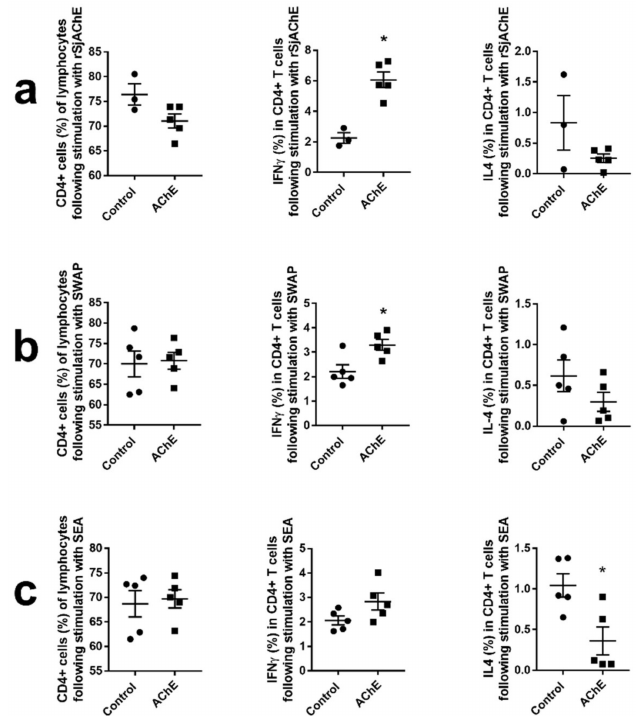
Figure 6. Cytokine profiles of splenocytes recovered from SjAChE-vaccinated and control mice at 6 weeks post- challenge. CD4 + T cells as a percentage of total lymphocytes and production of IFN γ and IL-4 in splenic CD4 + T cells isolated from vaccinated mice compared with controls following stimulation with ( a ) rSjAChE protein; ( b ) SWAP and ( c ) SEA for 3 days. * = p value ≤